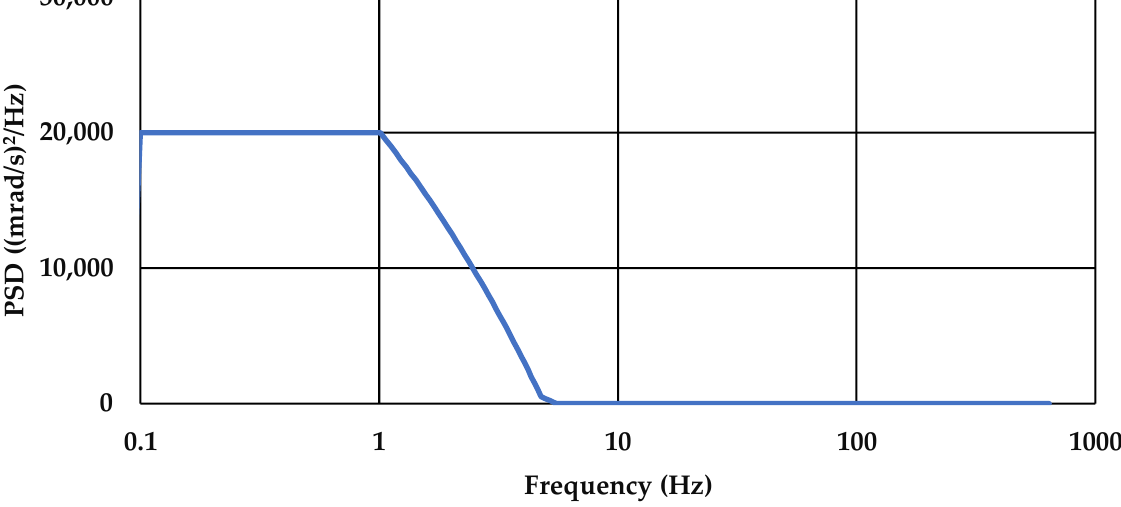
Figure 2. Base motion power spectral density.